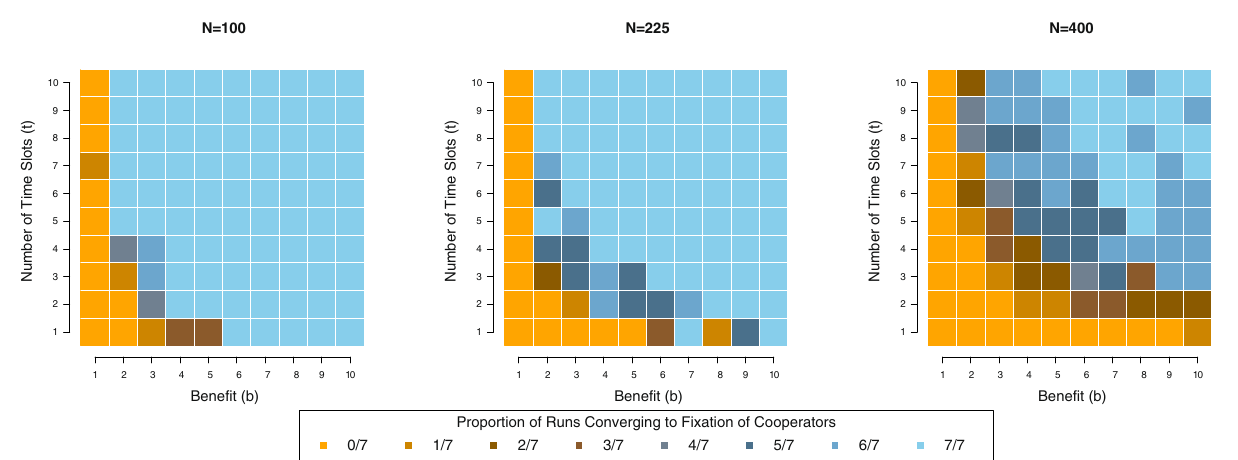
Fig. 3 Cooperator fi xation becomes more frequent across runs as bene fi t ( b ) and the number of time slots ( t ) increase in the lattice model. We replicate our simulation for 7 runs at each parameter setting and display how the proportion of runs reaching fi xation of cooperators varies by the values of b (horizontal axis) and t (vertical axis), displaying results for each value of N separately (as listed above each panel). Cooperation effectively never reaches fi xation when b = 1, signifying the dearth of gains cooperators obtain even when interacting with each other in such situations. With b > 2, we observe populations in which cooperators grow to fi xation; the prevalence of light blue tiles in the northeast corner of the grids indicates the increased success of cooperation when both b and t take large values within the model ’ s parameter range. Notably, we observe less instances of cooperators reaching fi xation as population size grows; as discussed in the text, this pattern relates to the speed of cooperators ’ growth as opposed to their ultimate success.